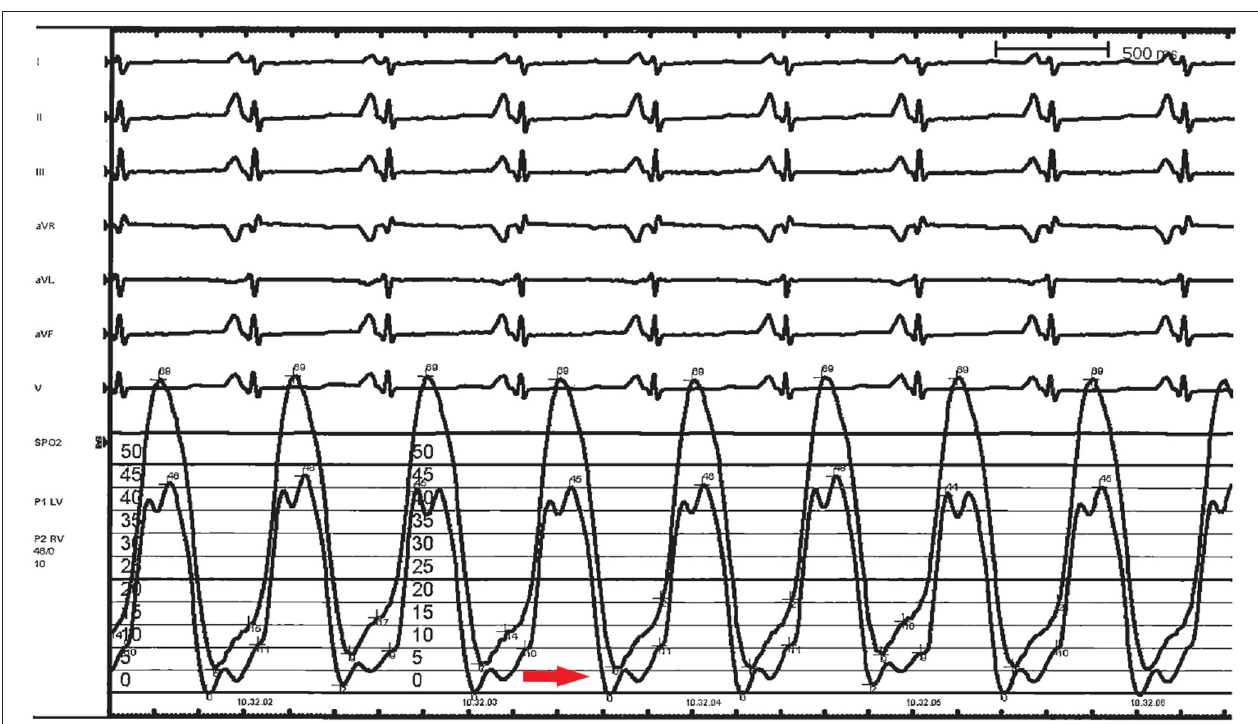
FIGURE 7 | Left ventricular (LV) and right ventricular (RV) hemodynamic pressure tracings in a 3-year-old girl affected by restrictive cardiomyopathy. End-diastolic filling pressures are elevated, with LV values higher than those in RV, and a “square root” sign is present on both tracings (red